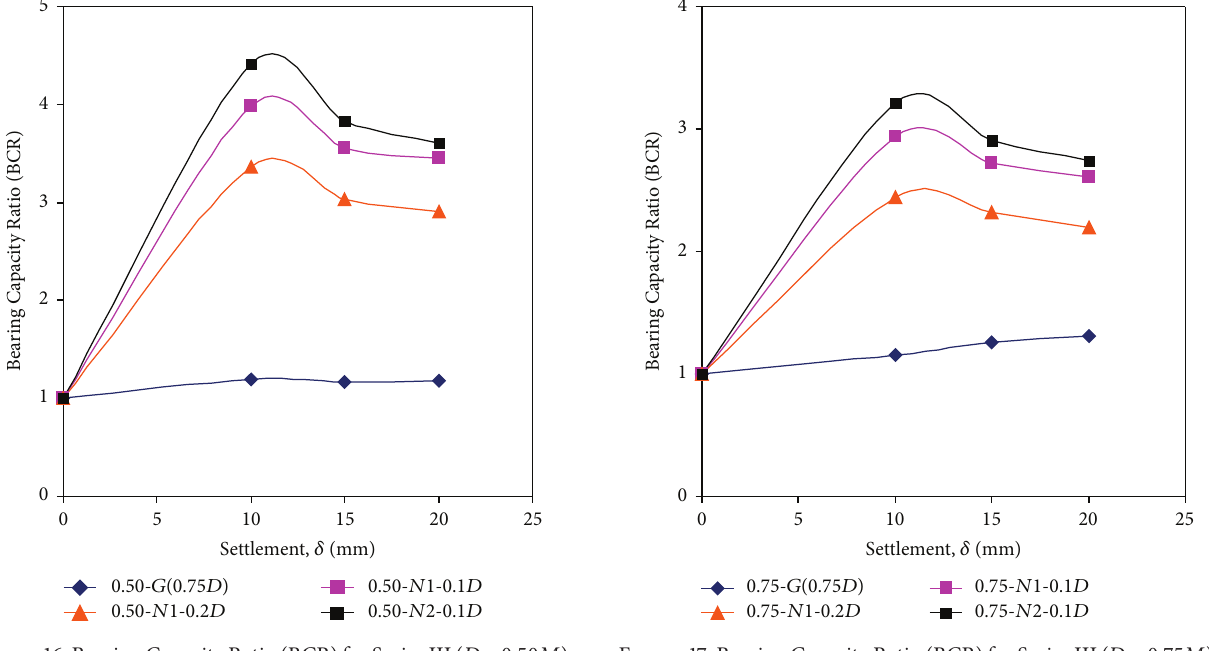
Figure 16: Bearing Capacity Ratio (BCR) for Series III ( 𝐷 = 0.50 𝑀 ), comparison.